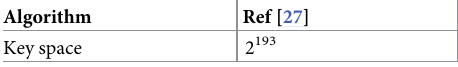
Table 3. Comparison of key spaces. Algorithm